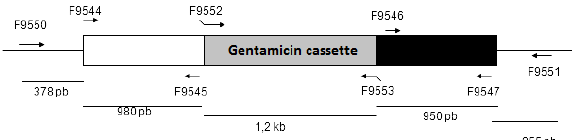
Figure 1. Descriptive schema of primer positions used for the generation of a gentamicin insert, with upstream (white fragment) and downstream (black fragment) re- gions of mutant strain indicated.